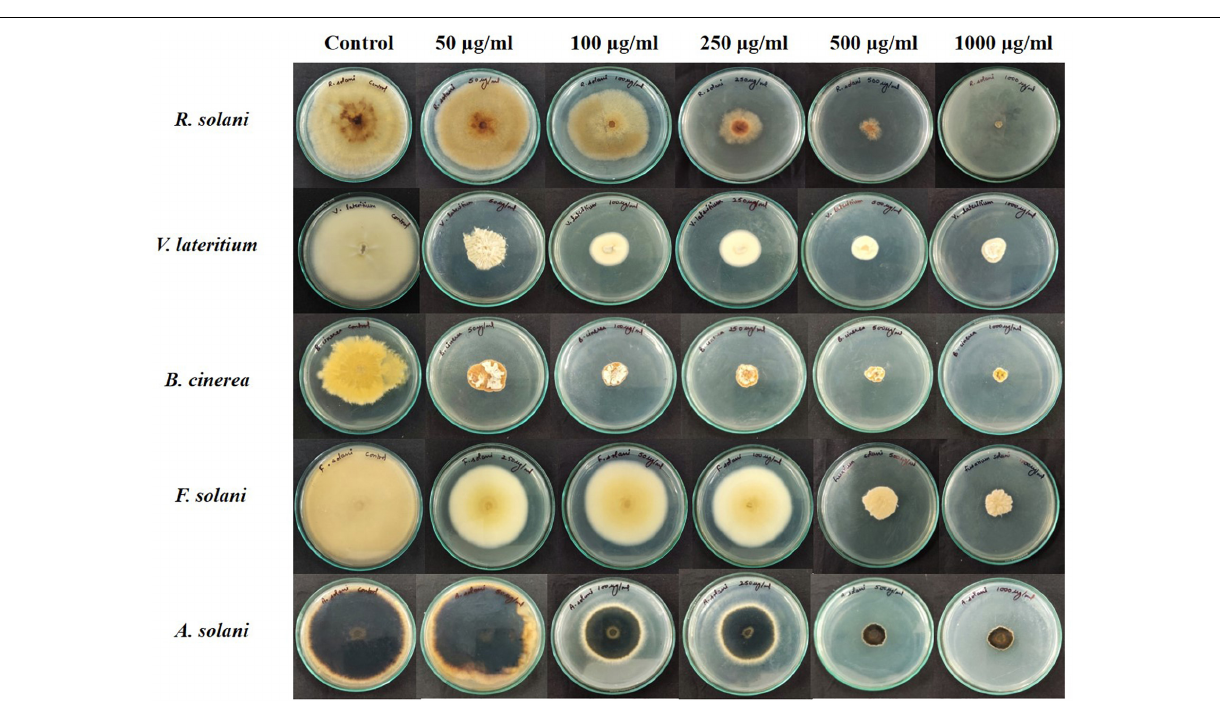
Frontiers in Microbiology |